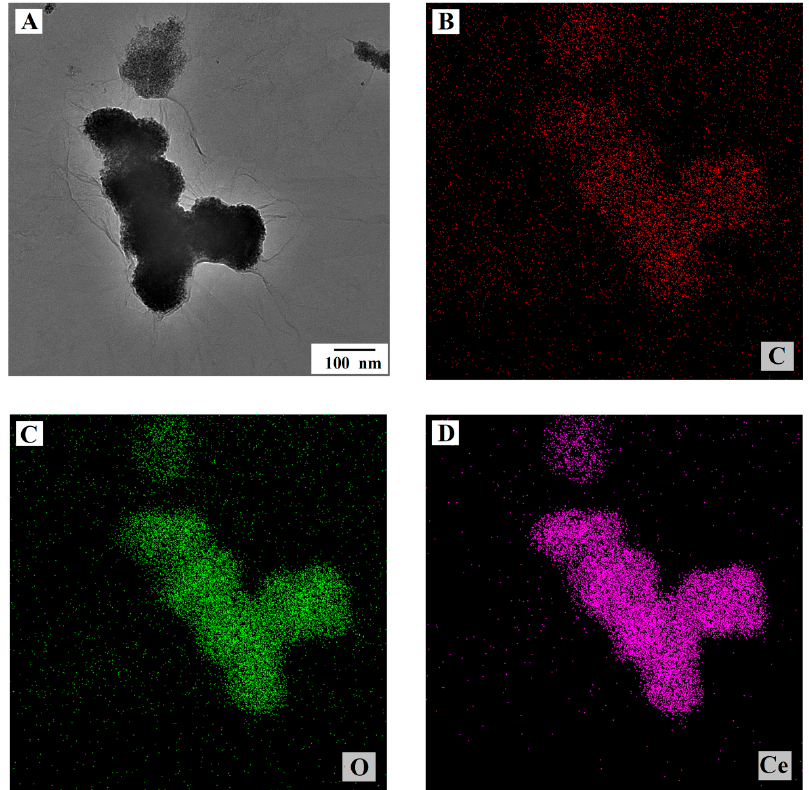
Figure 2. ( A ) TEM image of CeO 2 -ERGO nanocomposite; ( B – D ) Element mapping images of C, O and Ce of CeO 2 -ERGO composites.